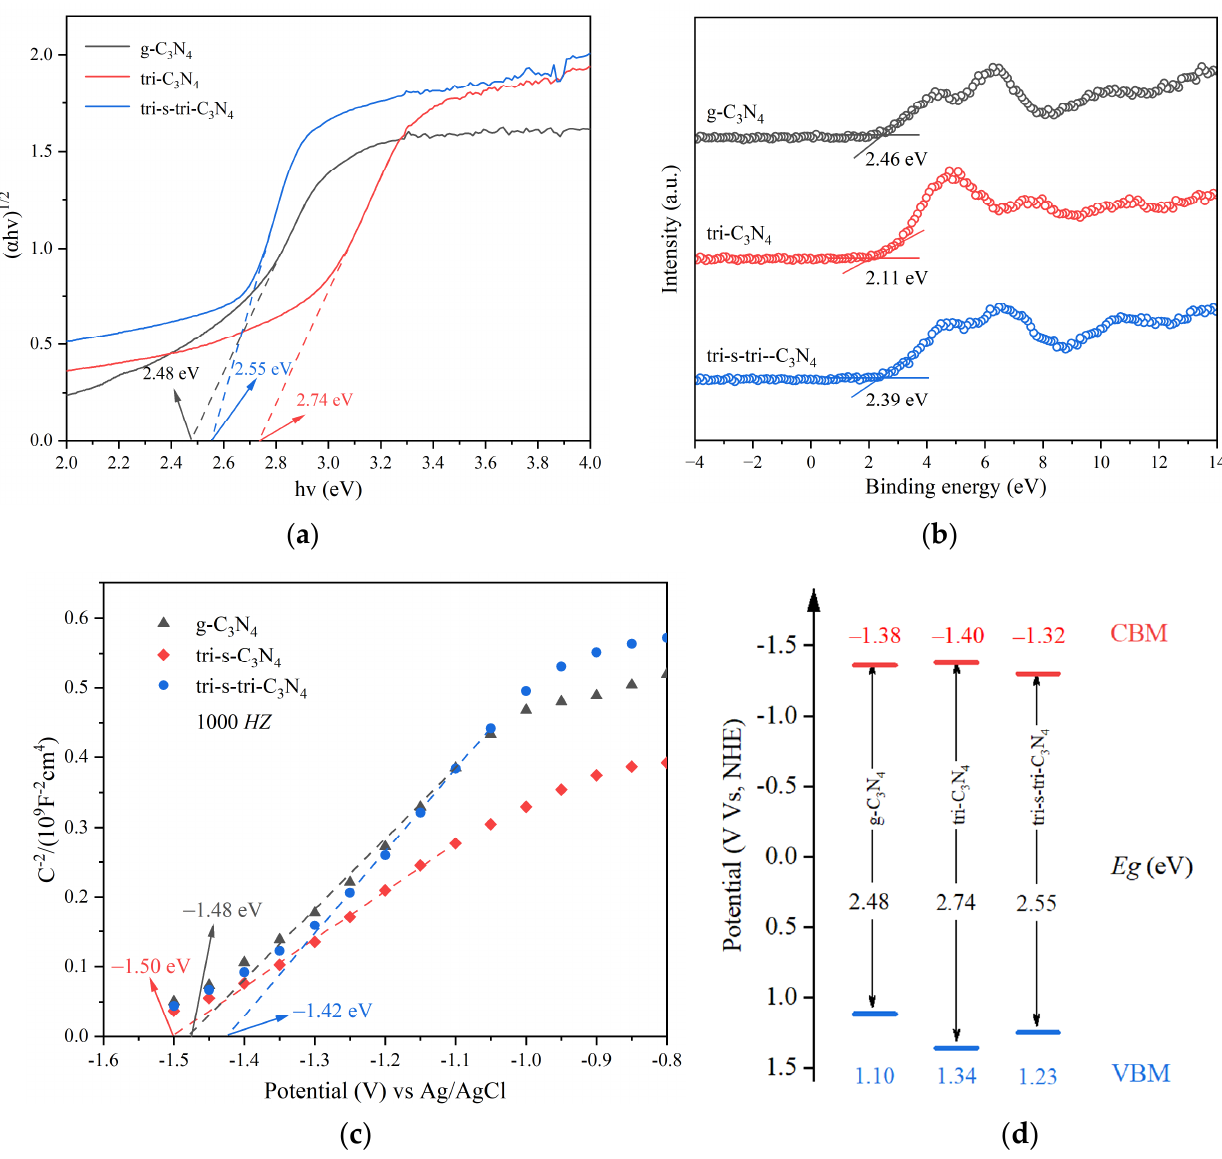
Figure 11. Kubelka–Munk diagram ( a ), XPS valence band map ( b ), Mott–Schottky plots ( c ), and bandgap structure ( d ) of materials.